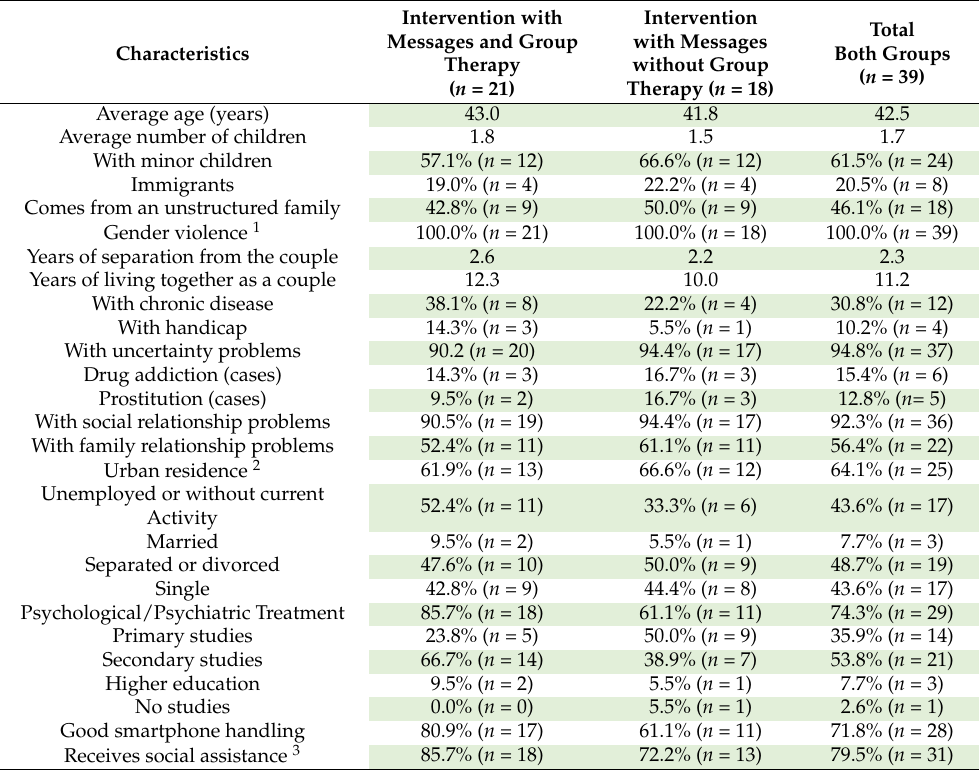
Table 1. Characteristics of the participating women ( n =